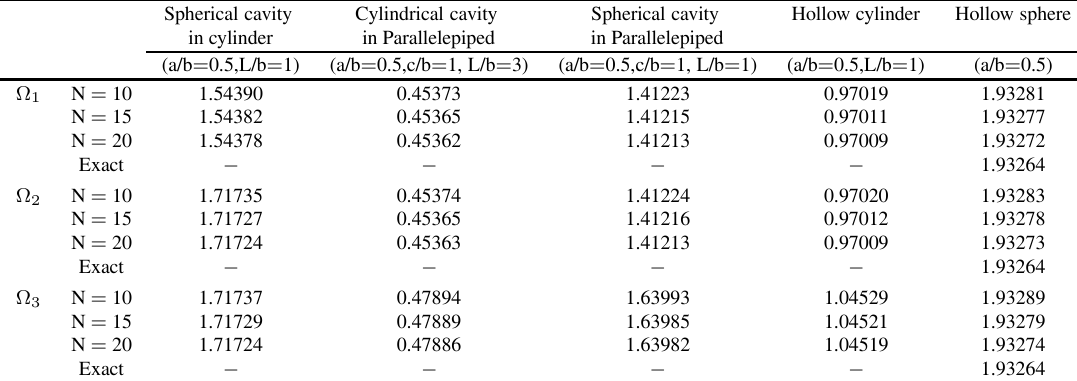
Table 1 The convergence rates of the fi rst three natural frequencies ofthe considered class of traction-free elastic bodies for selected